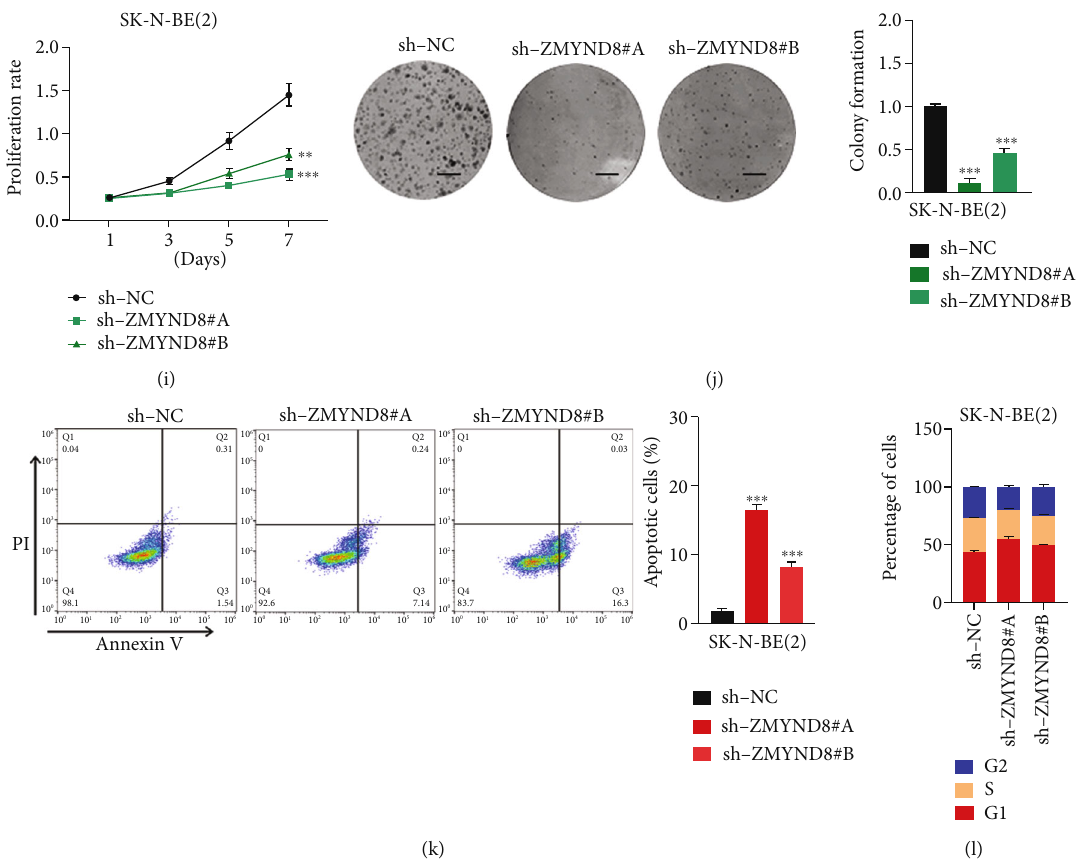
Figure 6: dBET57 treatment downregulates the superenhancer-related gene ZMYND8 in NB. (a) RNA-seq volcanic map of dBET57. (b) Heat map of di ff erentially expressed genes ( ∣ log 2FoldChange ∣ >0 : 5 , p ð adjusted p values Þ < 0 : 05 ) in SK-N-BE(2) cells treated with 1200nM dBET57, each column represents a sample, each row represents a gene, blue represents gene downregulation, and red represents gene upregulation. (c) ZMYND8 protein level decreased in a gradient-dependent manner with dBET57 concentration. (d) The IGV diagram shows the CHIP-seq spectrum of downstream indicator genes. (e) Tumor pro fi le of ZMYND8-speci fi c expression (CCLE). (f) Expression of ZMYND8 in NB and NC cells. p value was determined by unpaired two-sided t -test. (g) The prognosis of ZMYND8. p value was determined by log-rank test. (h) ZMYND8 mRNA and protein expression level in SK-N-BE(2) cell. (i) Cell proliferation ability of sh-NC and sh-ZMYND8. (j) Clonogenic ability of sh-NC and sh-ZMYND8. Scale bars: 4mm. (k) Apoptosis ability of sh-NC and sh- ZMYND8. (l) Cellular distribution of sh-NC and sh-ZMYND8. Each sh-ZMYND8 group was compared with the sh-NC group. ∗ p < 0 : 05 , ∗∗ p < 0 : 01 , and ∗∗∗ p < 0 : 001 ; ns: not signi fi